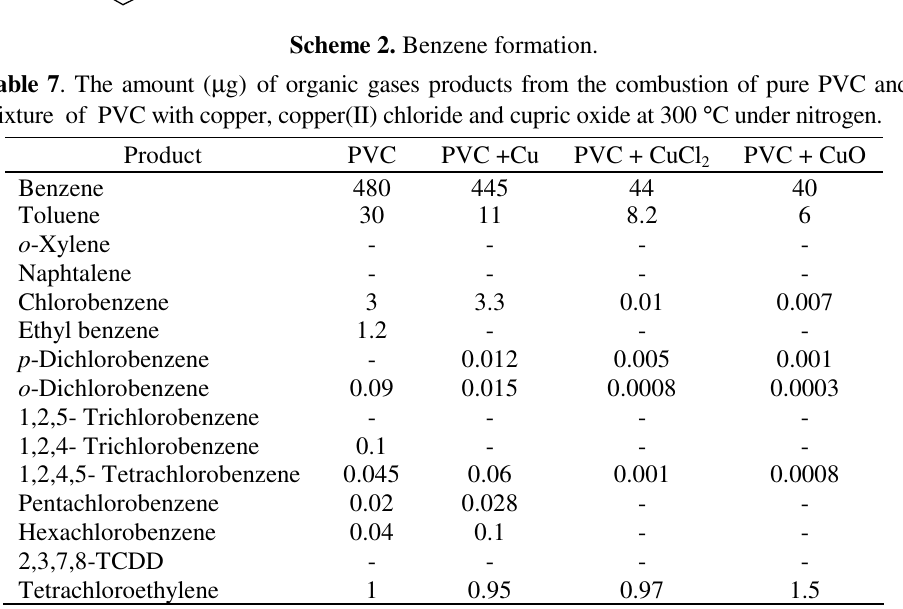
Table 8 . The amount ( µ g) of organic gases products from the combustion of pure PVC and PVC in the presence of copper, copper(II) chloride and cupric oxide at 600 ° C under